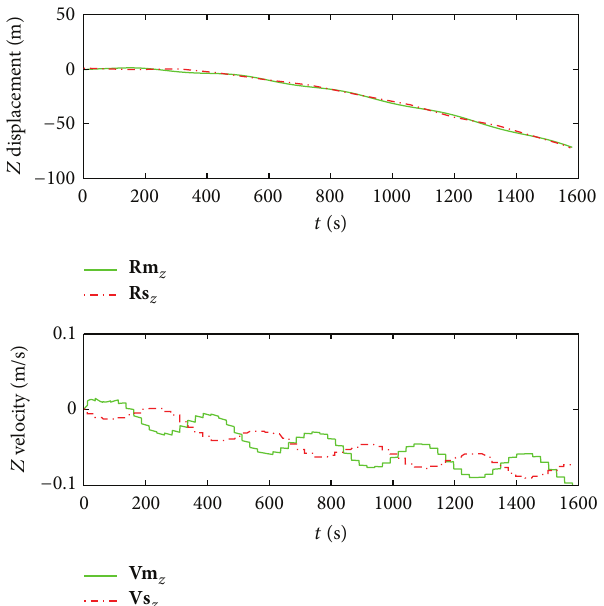
Figure 10: The out-plane positions and velocities of ROGER (m) and abandoned (s)